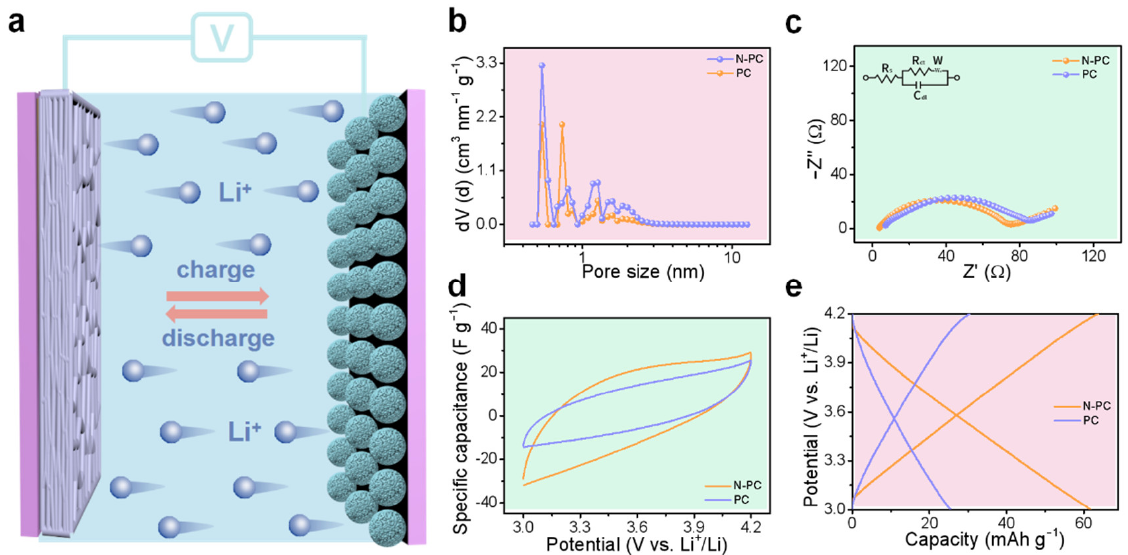
Figure 4. Electrochemical properties of the N−PC cathode. ( a ) Schematic diagram of charge trans- portation for the N−PC cathode. ( b ) Pore size distribution of N−PC and PC. ( c ) Nyquist plots. ( d ) CV curves at a scan rate of 10 mV s −1 . ( e ) GCD curves at a current density of 0.1 A g −1 .